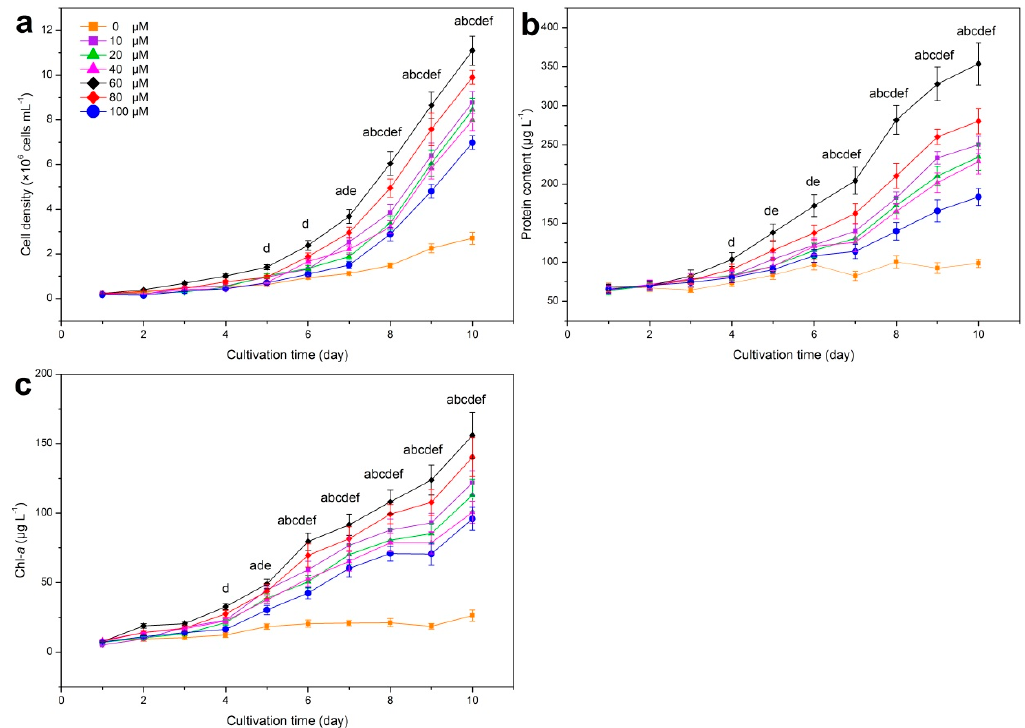
Figure 1. Cell density ( a ), protein content ( b ) and Chl- a (chlorophyll- a ) content ( c ) of M. aeruginosa ( Microcystis aeruginosa ) FACHB–905 under different iron conditions. Error bars represent the standard deviation of triplicate samples. a, significant difference between 10 µ M exposure and control exposure on the same cultivation day; b, 20 µ M–0 µ M; c, 40 µ M–0 µ M; d, 60 µ M–0 µ M; e, 80 µ M–0 µ M; f, 100 µ M–0 µ M. p < 0.05 was accepted as statistically significant for